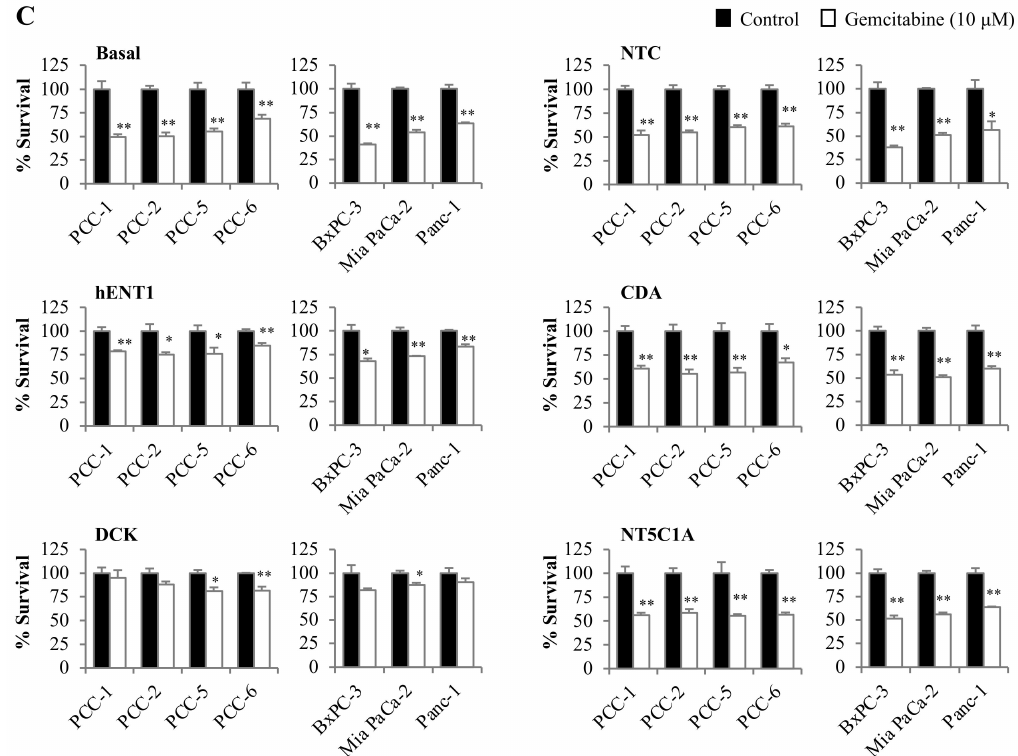
Figure 6. Gemcitabine transport and cytotoxicity assessment following inhibition of key regulators of gemcitabine uptake and metabolism. Human PDAC-derived PCCs (passage-7) and PDAC cell lines were transiently transfected with negative control siRNA (NTC) or siRNA against hENT1, CDA, DCK, or NT5C1A. ( A ) Cells incubated for 72 h post-transfection were lysed and proteins, subjected to immunoblotting using antibodies against the indicated targets. GAPDH was used as a loading control. ( B ) Gemcitabine uptake in cells pre-incubated with hENT1 inhibitor NBMPR or transfected with NTC or siRNA against hENT1, followed by exposure to [ 3 H]-gemcitabine (50 nM) for 4 h. ** p < 0.01 for control vs. NBMPR or NTC vs. hENT1 siRNA. ( C ) Non-transfected (Basal) cells and cells transfected for the indicated targets were exposed to gemcitabine (10 µ M) for 48 h and assessed for MTT-based cell viability. * p < 0.05, ** p < 0.01 for control vs. gemcitabine. Data are mean ± SEM of four replicates ( B , C ). CDA, cytidine deaminase; DCK, deoxycytidine kinase; hENT1, human equilibrative nucleoside transporter 1; NTC, negative transfection control; NT5C1A, 5 (cid:48) -nucleotidase cytosolic 1A; PCC, pancreatic cancer